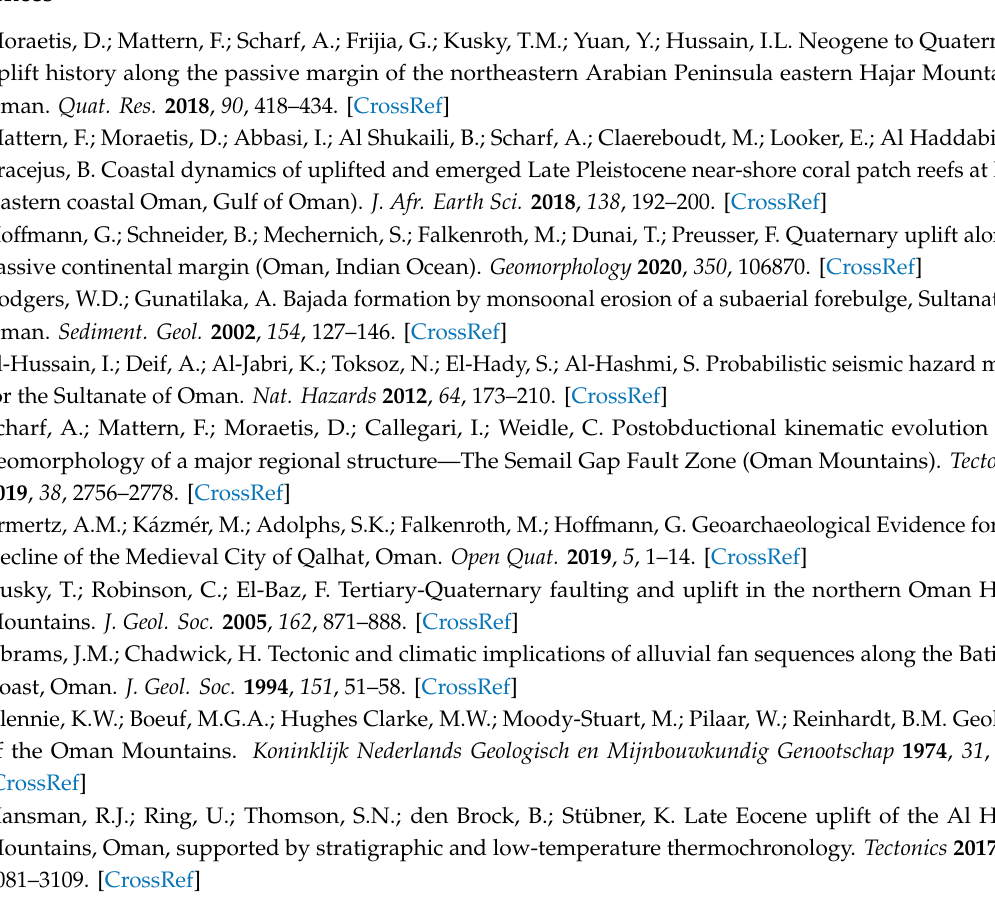
Figure S1a: Sample position for OSL analysis which is next to fault 5 (overview), Figure S1b: Sample position for OSL analysis which is next to fault 5 (detailed view), Figure S2: Detailed map of the study area, depicting di ff erent nappes within the Hawasina units and its thrust contacts, Figure S3: Schematic map depicting the thrust faults within the Hawasina nappes and the Semail Ophiolite, Table S1: Equivalent Dose (De) and Environmental dose rate (Dr)